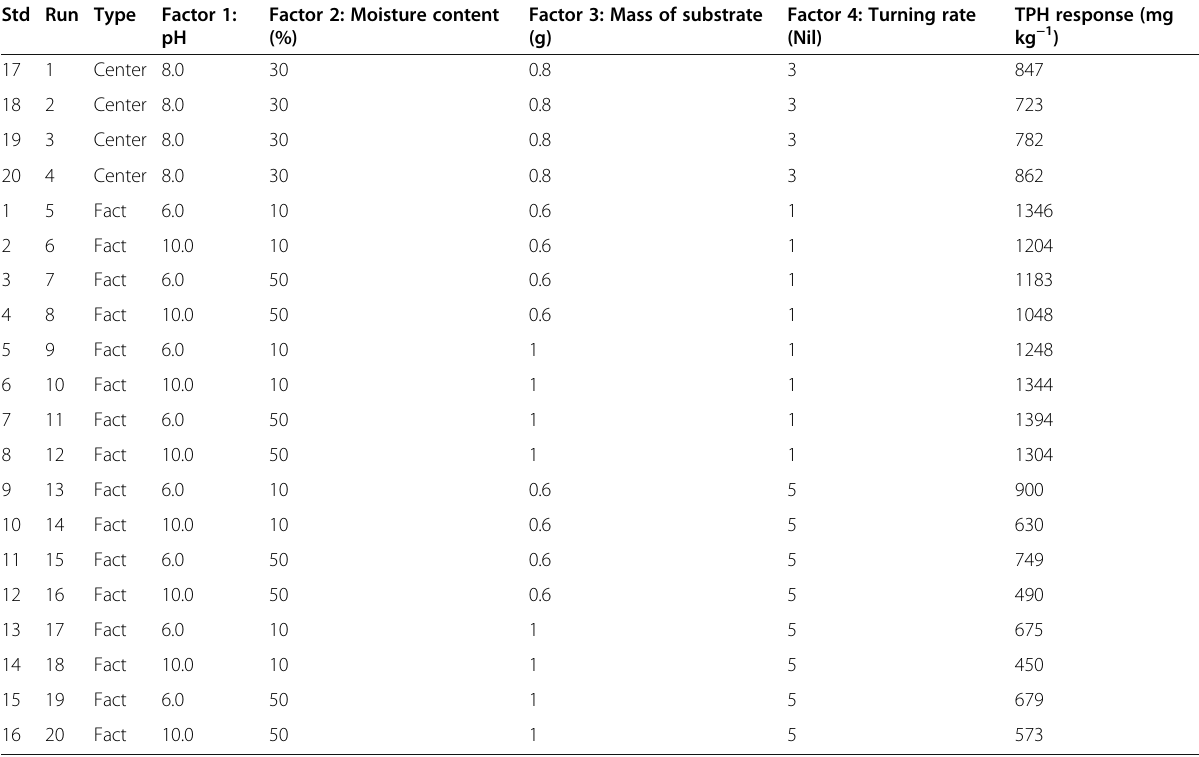
Table 4 Response of TPH on factorial design of experiment used for variable screening Std Run